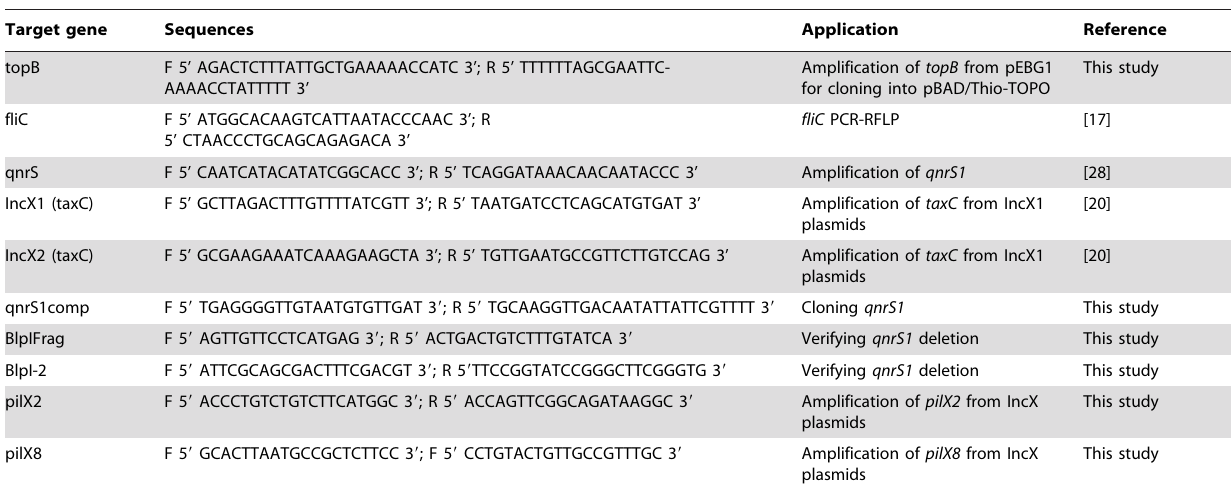
Table 2. Oligonucleotide primers used for PCR.